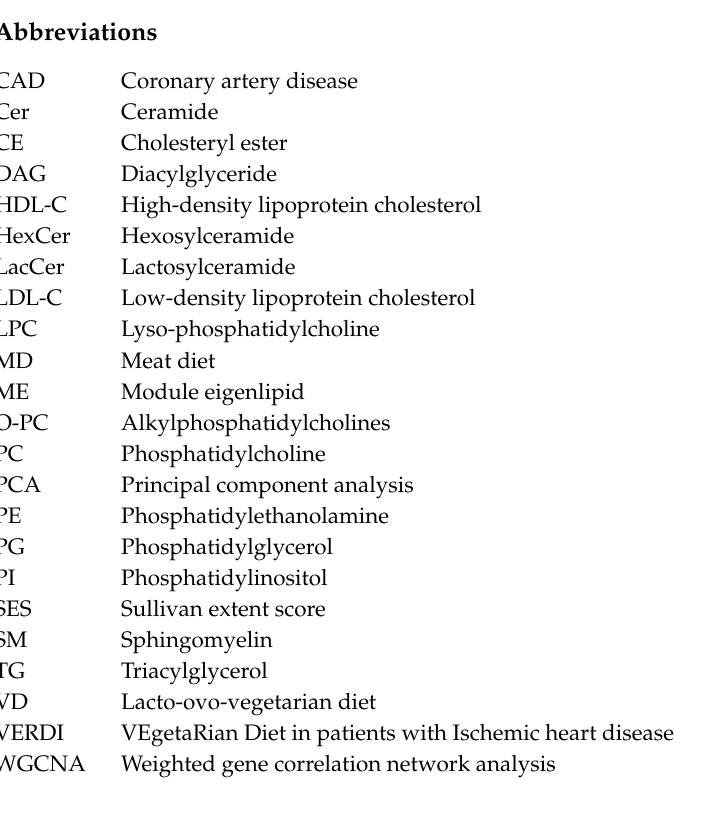
Figure S1: The model performance and permutation test of plasma lipid profiles at baseline and after wash-out period using the random forest modeling based multilevel data analysis, Figure S2: Data checking and power determined by Scale-Free Topology Criterion for the weighted gene correlation network analysis, Figure S3: Dendrogram created from a dynamic tree-cutting algorithm for the weighted gene correlation network analysis, Figure S4: The e ff ect of diet on plasma lipid profiles assessed by multilevel random forest modelling, Figure S5: The e ff ect of diet on plasma lipid profile, Table S1: Baseline characteristics of study participants in VERDI trial by number of stenotic coronary arteries and longitudinal atherosclerotic extent prior to percutanous coronary intervention, Table S2: Plasma lipidomic identification by lipid class and the clustering information obtained using the weighted gene correlation network analysis, Table S3: E ff ects of diets on plasma lipidome, Table S4: Cardiovascular risk factor levels after four weeks of a vegetarian diet compared to a meat diet, Table S5: Loadings of lipids that di ff ered between vegetarian diet and meat diet derived from principle component analysis, Table S6: Association of lipid levels with coronary artery disease burden, Table S7: Association of plasma lipid levels at baseline with coronary artery disease burden prior to percutanous coronary